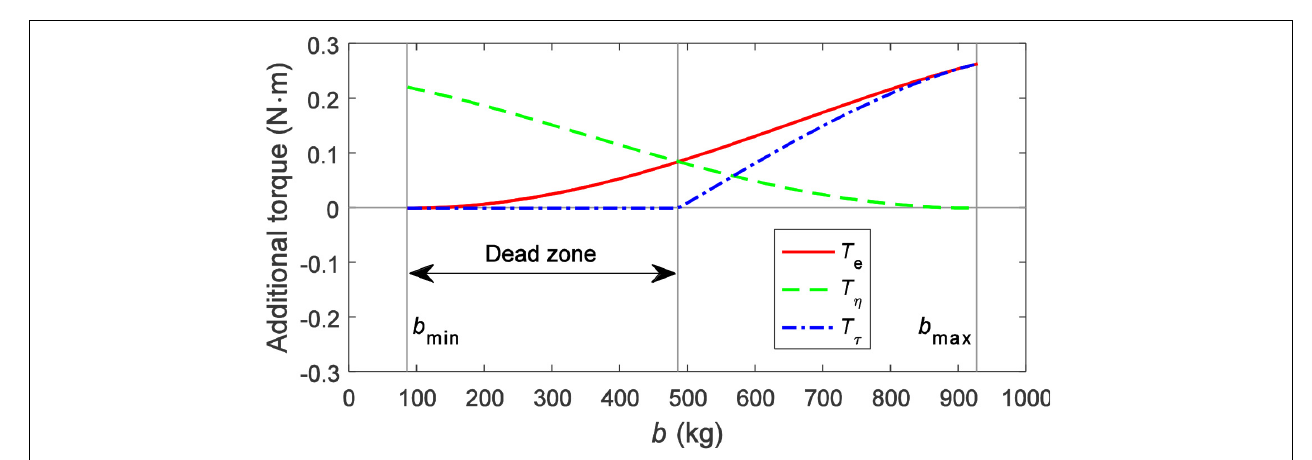
FIGURE 6 | Adjustment process of the inertance under an ideal situation.